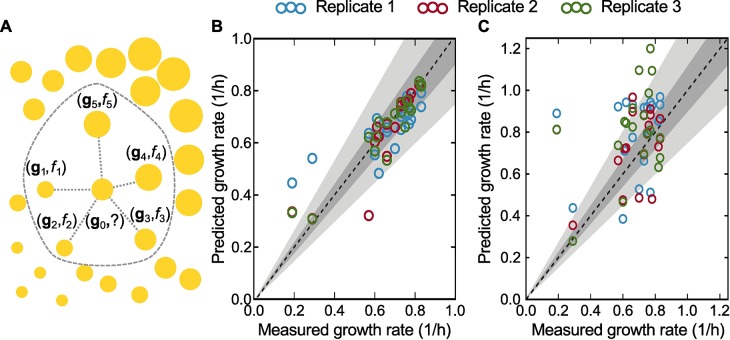
Description and validation of the k-nearest neighbors (KNN) model.(A) Illustration of our KNN model for estimating the (unknown, indicated by the question mark) growth rate associated with a given expression profile from the known growth rates for different expression profiles in its neighborhood. Circle centers and sizes indicate gene expression profiles (gi) and growth rate (fi), respectively. (B) Validation of the KNN model using the gene expression data from all 19 strains for which we measured both gene expression and growth rate in triplicate (underlined strains in Table 1). The KNN analysis was trained on a dataset comprising (i) the data curated in [59], (ii) our transcripomic and growth rate data, and (iii) randomly generated pseudo-profiles (see Materials and Methods for details) for a total of 11,275 datapoints. The dataset was partitioned into fifths that preserved the growth rate distribution and each combination of four fifths was used to train a KNN model that predicted the growth rate of the left-out fifth. For comparison with (C) only predictions regarding our transcriptomic growth data are retained. The figure shows good agreement between the resulting predicted growth rates and the experimentally measured growth rates (R2 = 0.84, p-value < 10−38), where the line of perfect agreement (dashed), 10% error (dark grey) and 25% error (light grey) are included as a reference. (C) Prediction of our measured growth rates by the KNN analysis when trained on publicly available data only. Results are presented for dataset D2 in S9 Table (R2 = 0.11, p-value < 0.015). Colors and dashed line have the same meaning as in (B). The accuracy in (C) is lower than in (B) because, with only a limited number of experiments to use for training, outlier transcriptional states remain under-sampled making it hard to resolve the growth rate of these states.